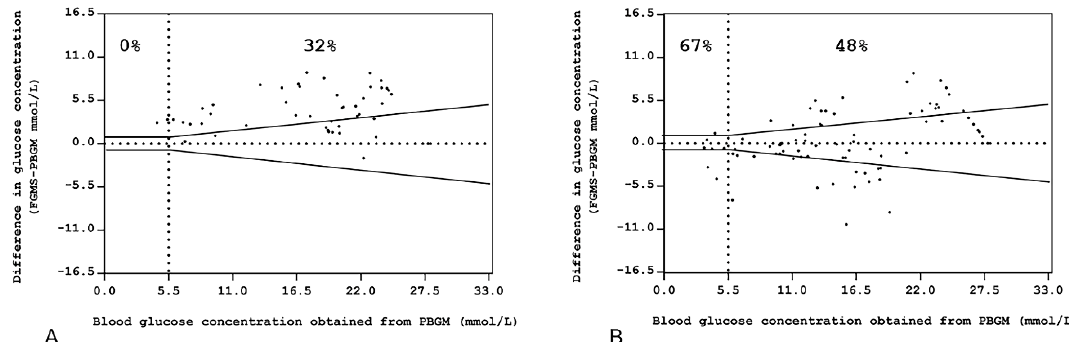
Figure 3. Bland–Altman plots represent the differences between the glucose concentrations obtained by the use of the FGMS versus those obtained using the PBGM in ( A ) Group 1 and ( B ) Group 2. The PBGM glucose values plotted against absolute errors for each corresponding value are on the x -axis. The standard required limits are defined by the black symmetric line: at ± 0.83 mmol/L (15 mg/dL) from the reference value for glucose determinations < 5.5 mmol/L (100 mg/dL) and ± 15% from the reference value for glucose determination > 5.5 mmol/L (100 mg/dL). Percentages express the number of samples within the limits when the reference determination was < or >5.5 mmol/L (100 mg/dL) and for the total number of measurements (central % value).